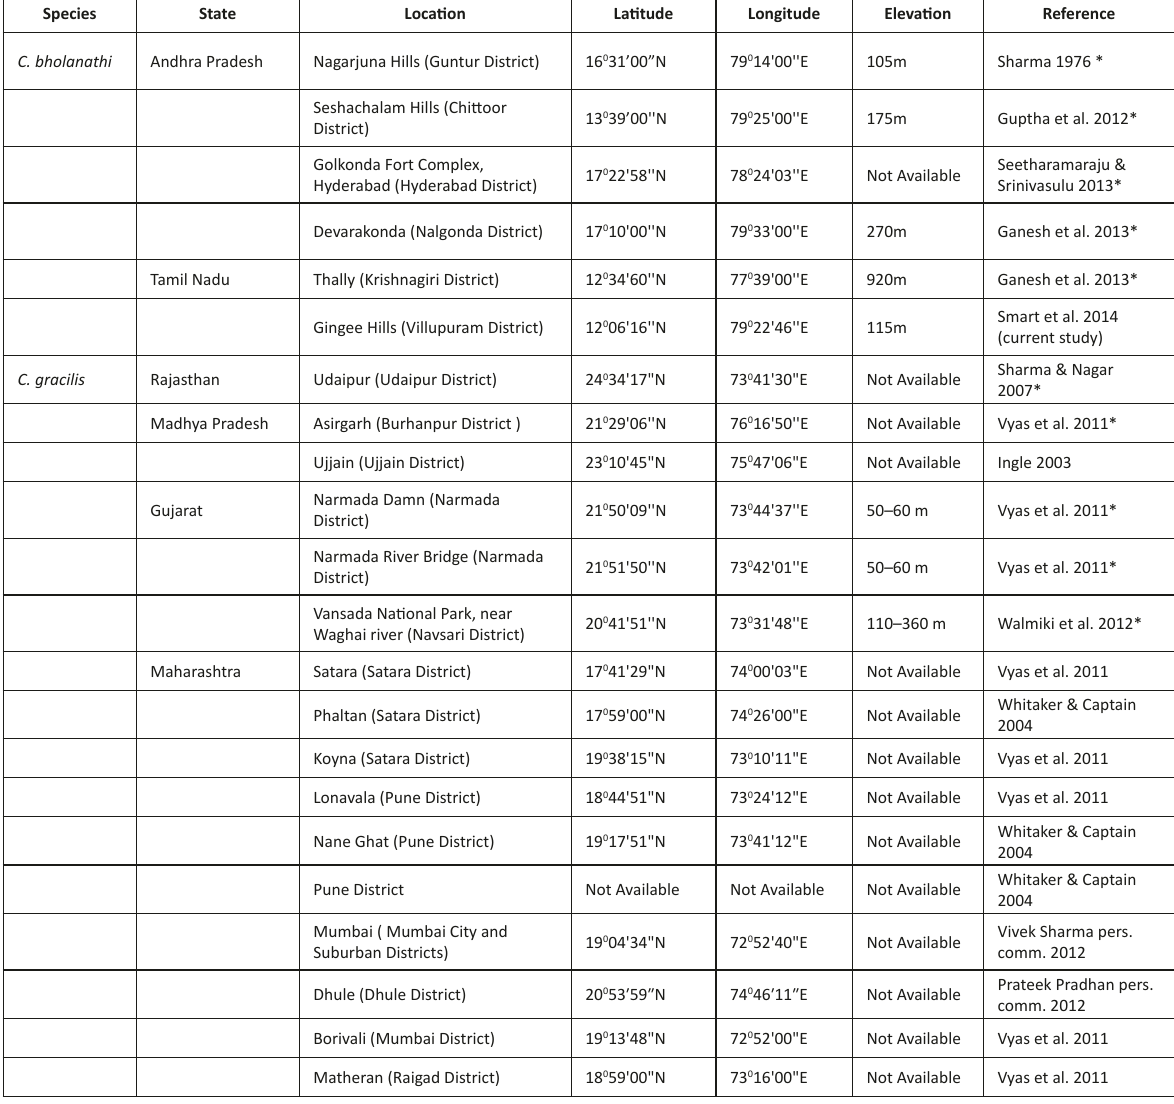
Table 1. Localities based on personal observation and literature for Coluber bholanathi and Coluber gracilis . The longitude and latitude for the rows with an * are published in literature, for every other locality we provide the coordinates of the city that is